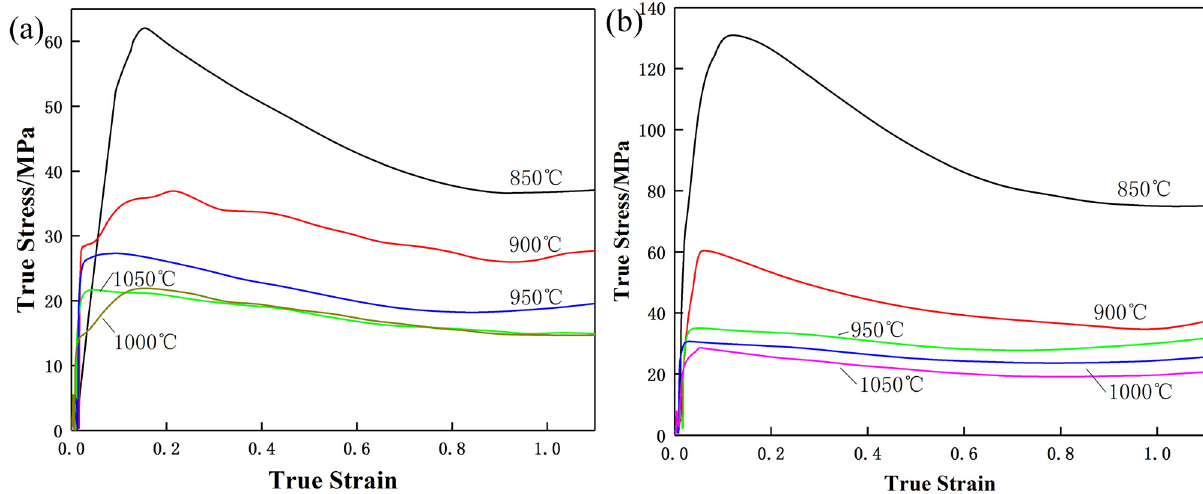
Figure 3: True stress – true strain curve of TC4 titanium alloy at the same strain rates and di ff erent temperatures: ( a ) 0.001 s − 1 and ( b ) 0.01 s − 1 .